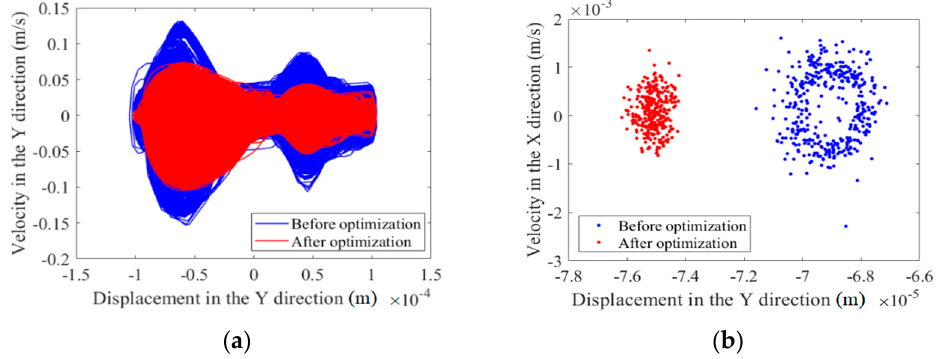
Figure 10. Nonlinear characteristics of joint B in the Y direction. ( a ) Phase map. ( b ) Poincaré map.